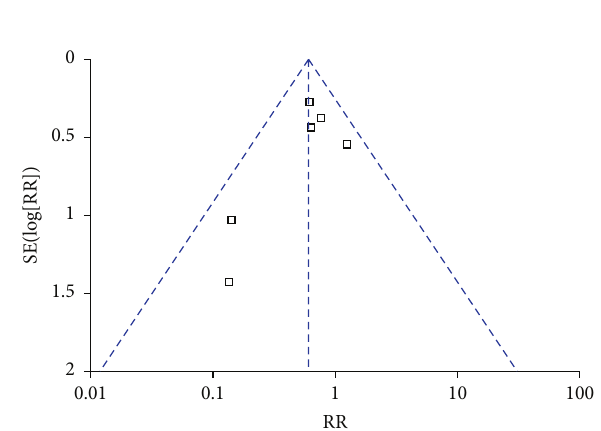
Figure 3: Funnel plot for publication